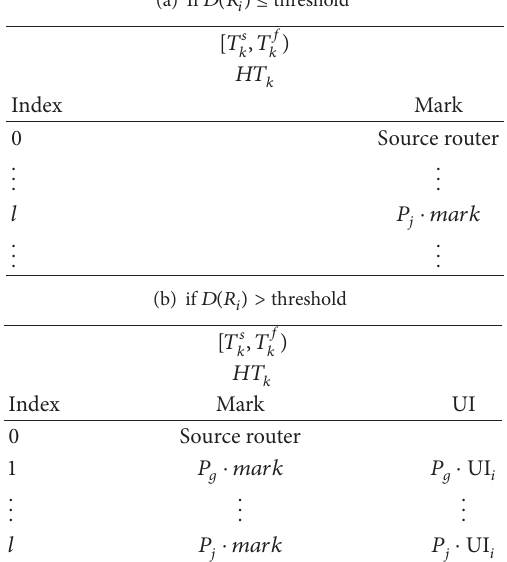
Figure 2(a) exemplifies our marking and logging